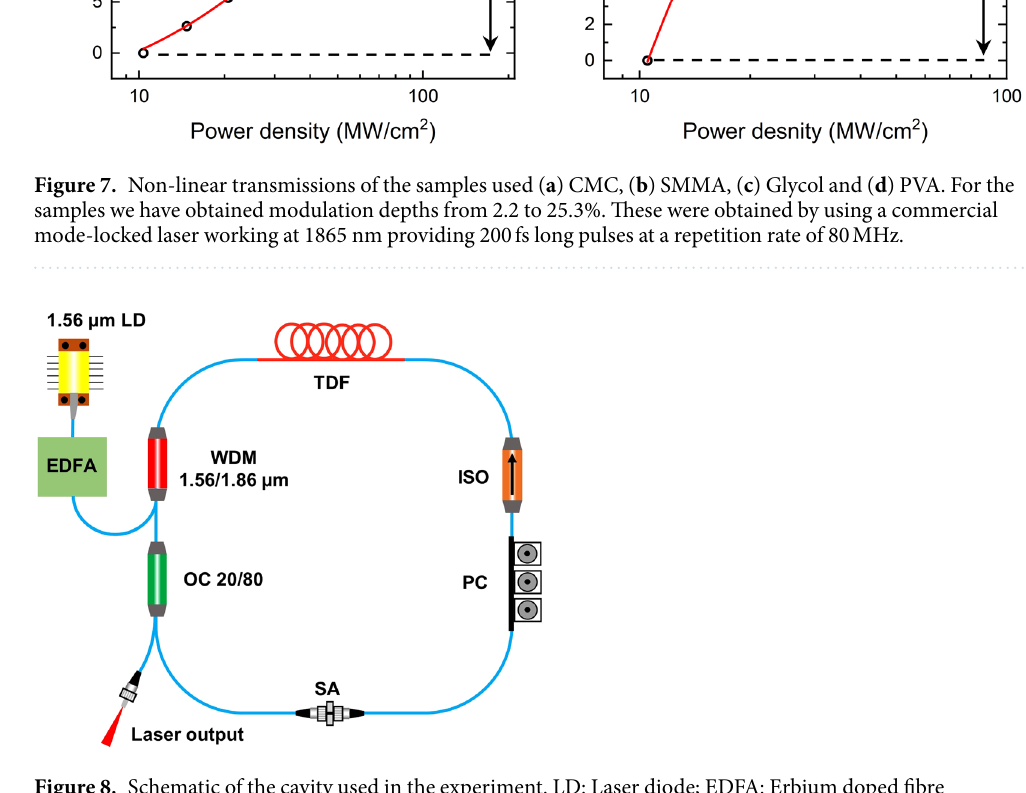
Figure 8. Schematic of the cavity used in the experiment. LD: Laser diode; EDFA: Erbium doped fibre amplifier; WDM: Wavelength division multiplexer; TDF: Thulium doped fibre; ISO: Isolator; PC: Polarization controller; SA: Saturable absorber OC: Optical coupler. Twenty percent of the power was taken out from the cavity for the characterisation of the laser (Image created with MS